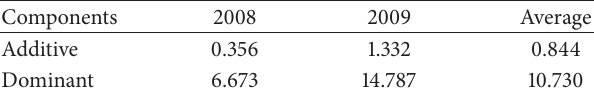
Table 4: Proportional contribution (%) of the lines, pollinators, and interactions to the expression of root